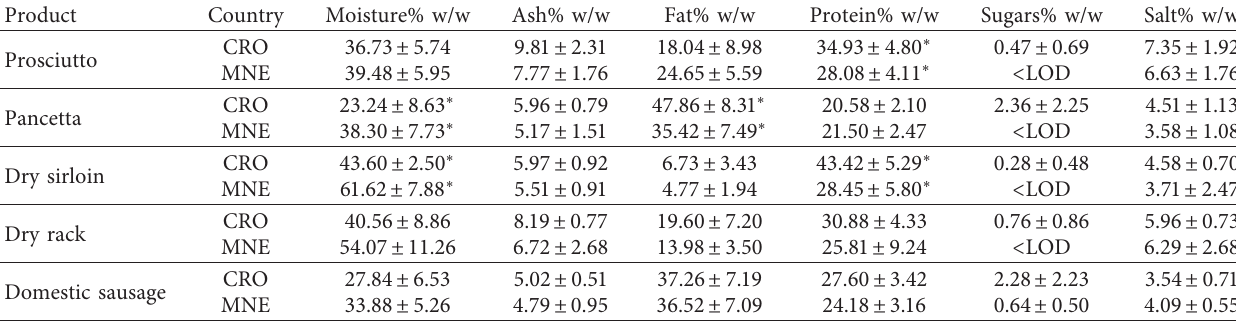
Table 2: Chemical composition of traditional Croatian and Montenegrin dry-cured meat products and dry-fermented sausages. Product